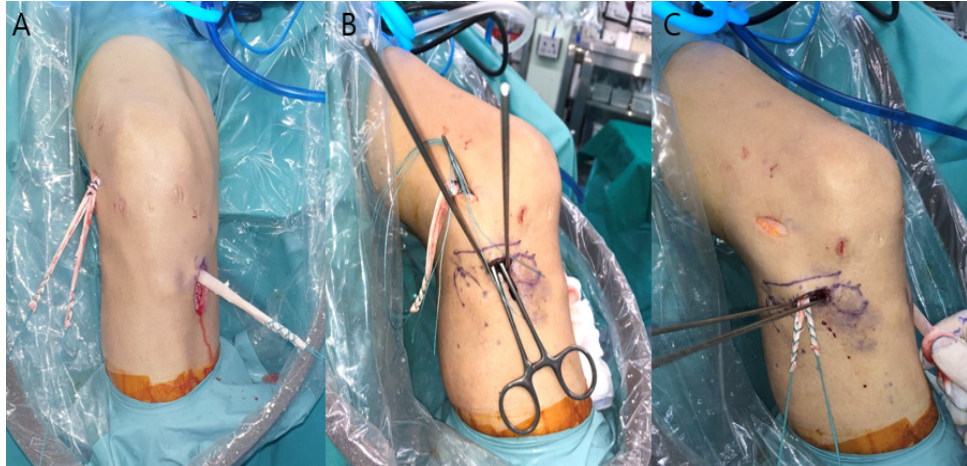
Figure 3. ( A ) ACL graft positioned in the femoral and tibial tunnels, and ALL graft pulled outside the femoral tunnel outlet. ( B , C ) Clamp passed deep into the iliotibial tract to drive the ALL graft into the tibial bony sockets.